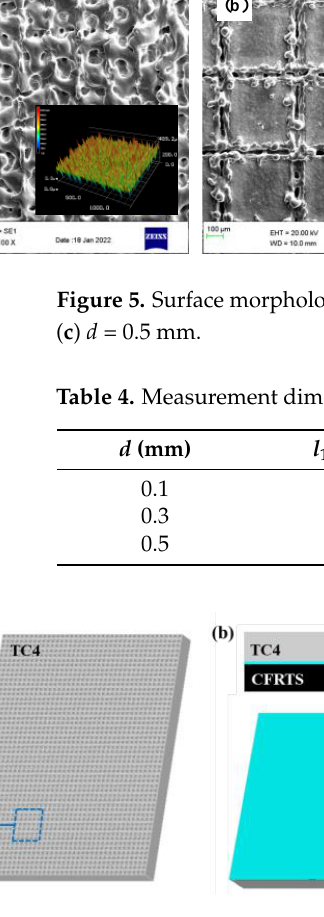
Figure 6. ( a ) Micro-texture geometric model; ( b ) anchorage model; ( c ) meshing model.